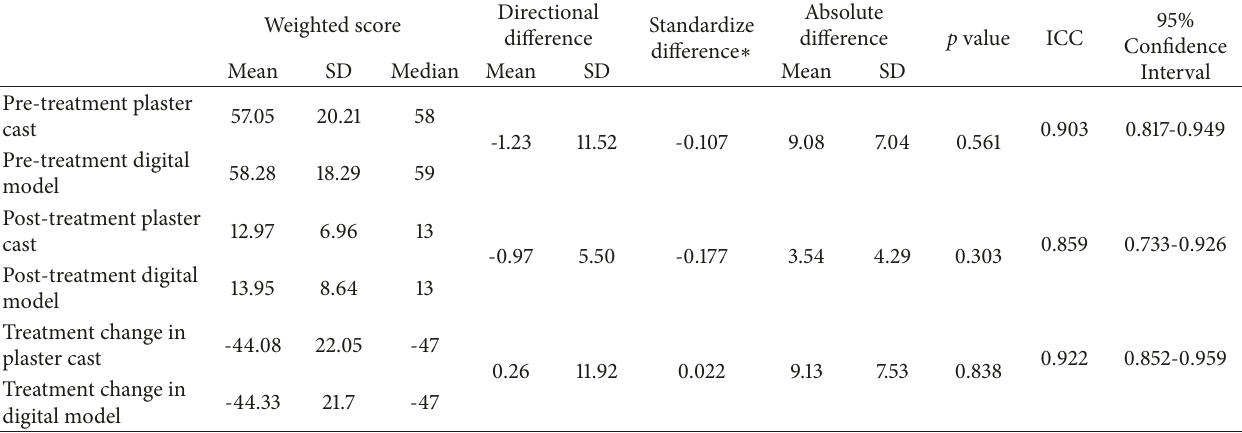
Table 3: Agreement between digital models and plaster casts in assessment of ICON. Weighted